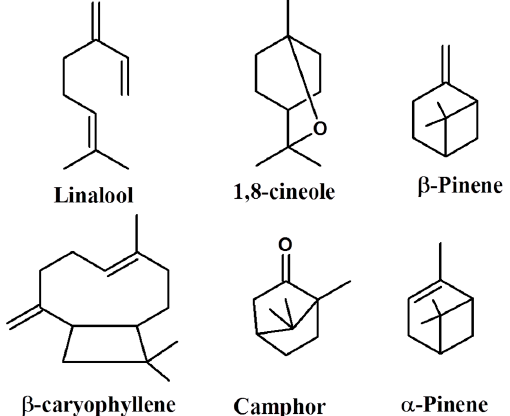
Molecules 2022 , 27 , x FOR PEER REVIEW Figure 1. The chemical structures of some of the major compounds in REO. Figure 1. The chemical structures of some of the major compounds in REO.